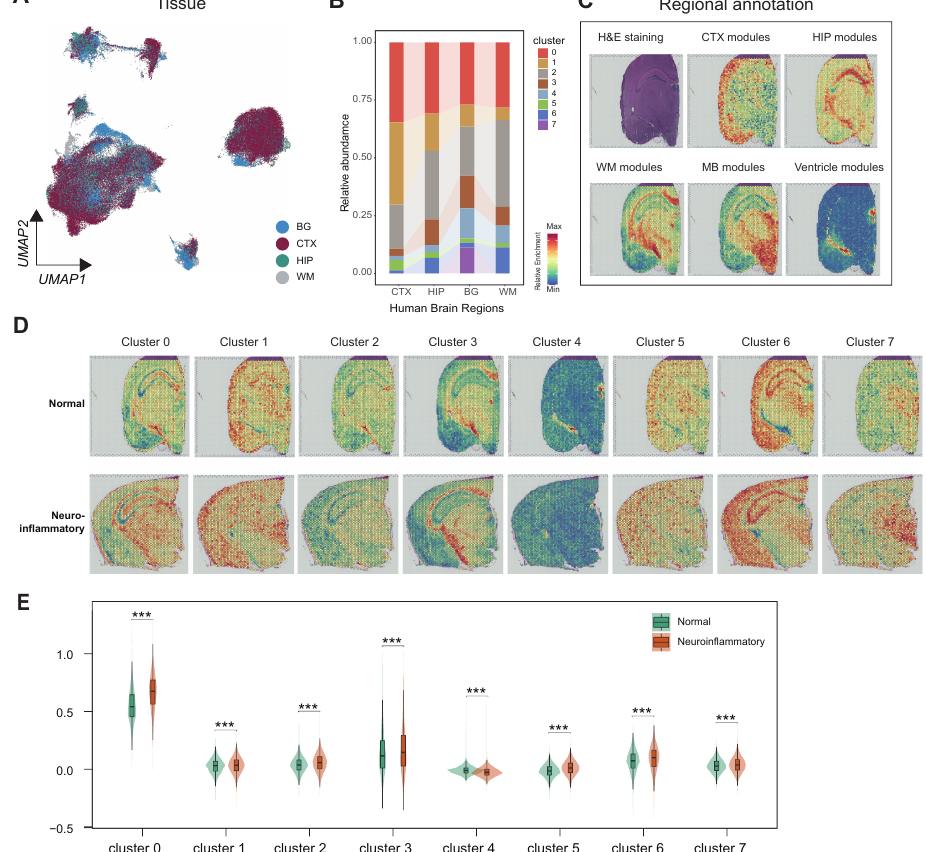
Figure 3. Astrocyte subtypes are regionally heterogeneous. ( A ) UMAP plot of astrocytes, colored by the human brain regions including basal ganglia (BG), cortex (CTX), hippocampus (HIP), and white matter (WM). ( B ) Relative proportions of astrocyte subtypes for samples from different brain regions. BG, N = 40; CTX, N = 209; HIP, N =16; WM, N = 29. ( C ) Identification of brain region locations using module scores of classical region-specific marker genes: CTX, HIP, WM, midbrain (MB), and ventricle modules. ( D ) The highlighted spatial distribution of 8 astrocyte subtype signatures in sections from normal (N = 3) and neuroinflammatory (N = 3) brains using Visium spatial transcriptomics. ( E ) Quantification of signature scores of the top 50 enriched genes for each cluster, across all spots from normal and neuroinflammatory samples. (*** p < 0.001, Kruskal–Wallis